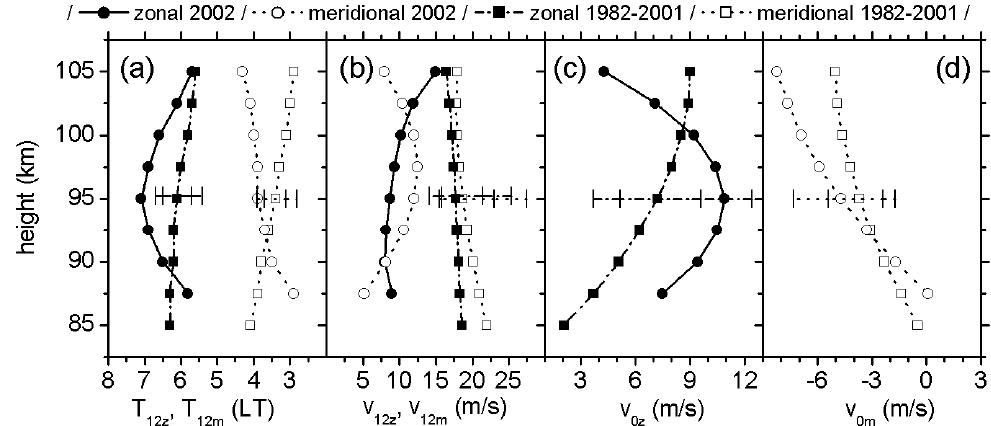
Fig. 2. September 2002 mean profiles of (a) SDT (b) SDT amplitudes (c) zonal prevailing winds and (d) meridional prevailing winds over Collm. The circles show the 2002 values, while squares denote the climatological 20-year mean values calculated from all September data between 1982 and 2001. The horizontal bars show the maximum/minimum values and the 1 − σ variation during that time